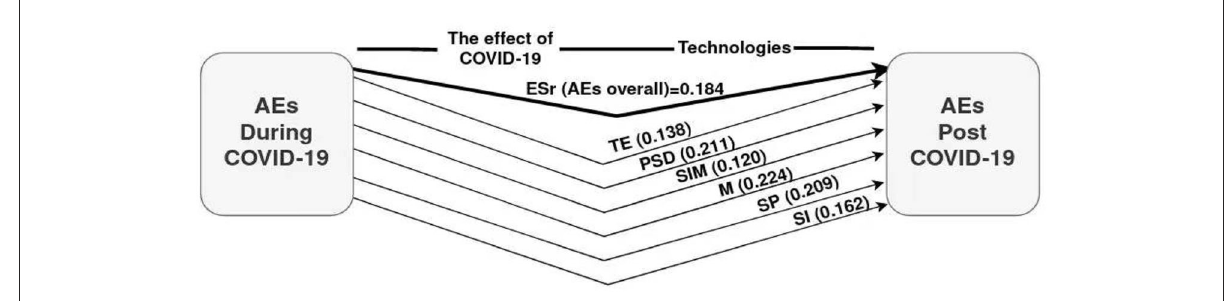
FIGURE3 The effect size of COVID-19 on the AEs model.